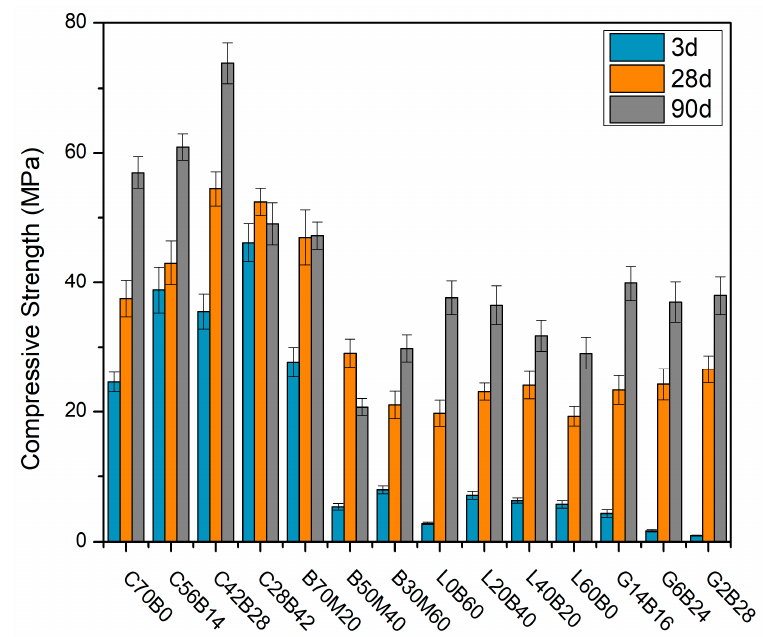
Figure 2. Compressive strength evolution of all mixtures during the 90-day period. Error bars are equal to one standard deviation of the mean on each side.